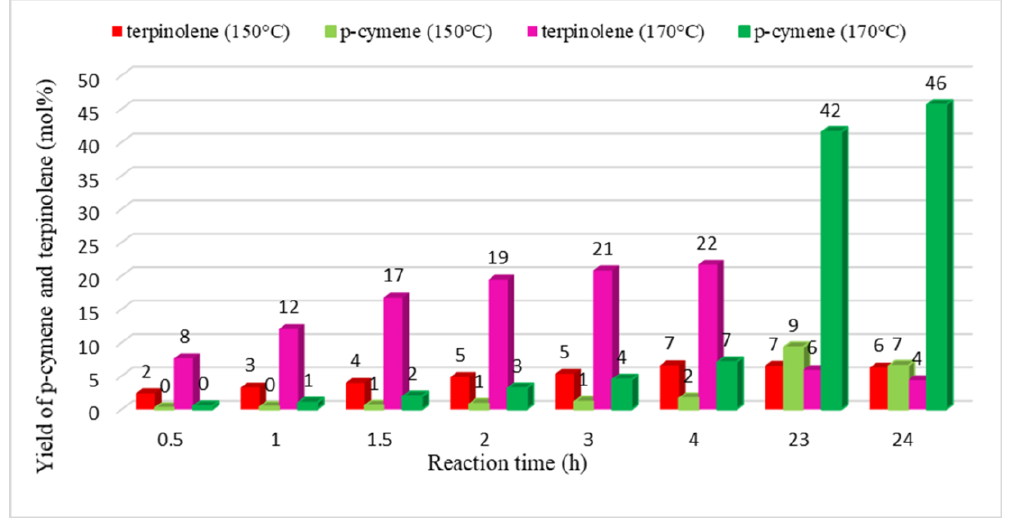
Figure 5. The influence of temperature (150 °C or 170 °C) on the yield of the main products of the limonene isomerization process. The amount of the catalyst was 15 wt